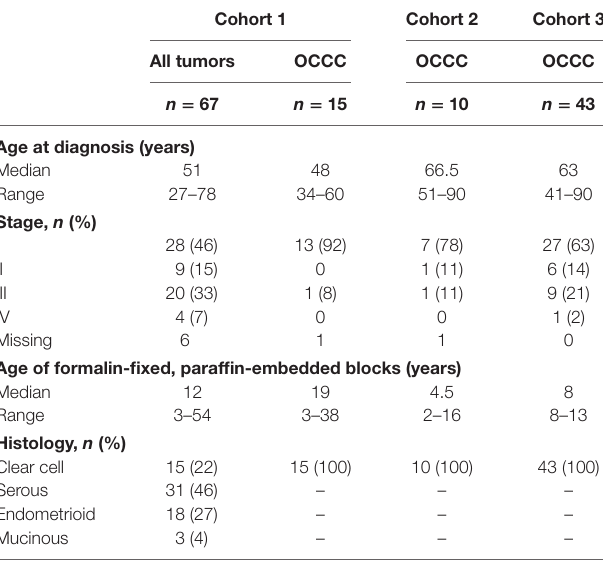
TaBle 2 | clinical characteristics of ovarian clear cell carcinomas (Occcs) in the study